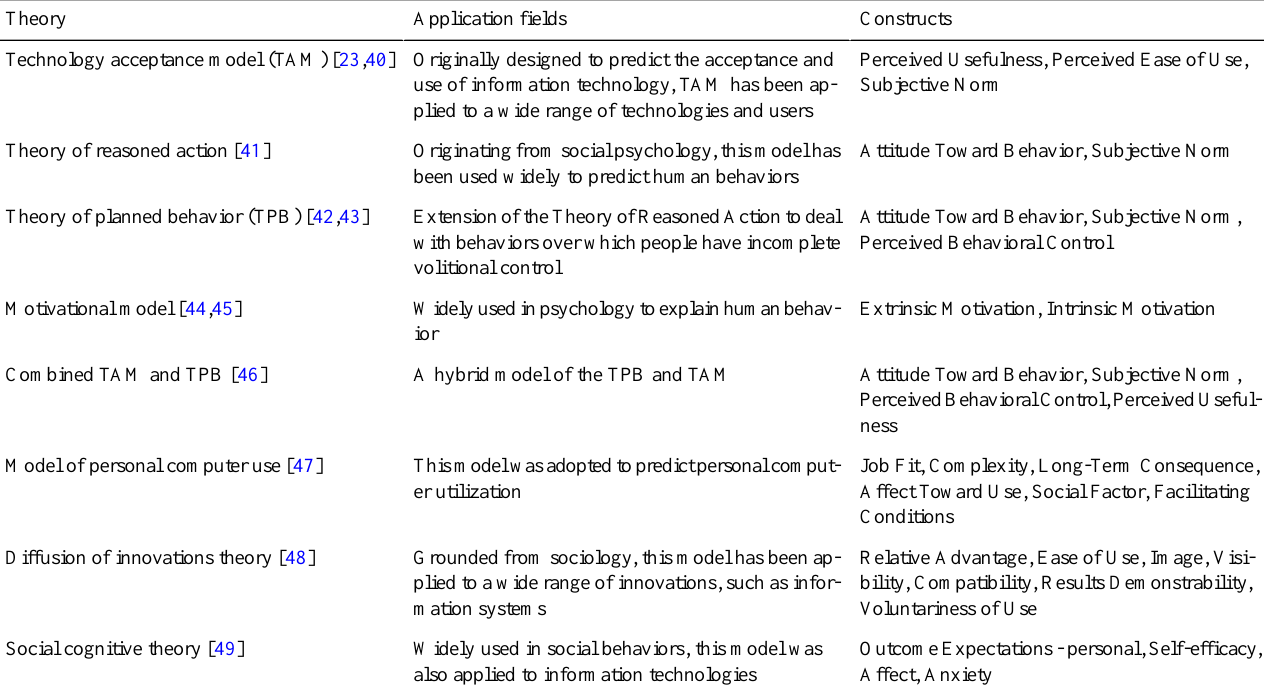
Table 1. Summary of technology acceptance theories.